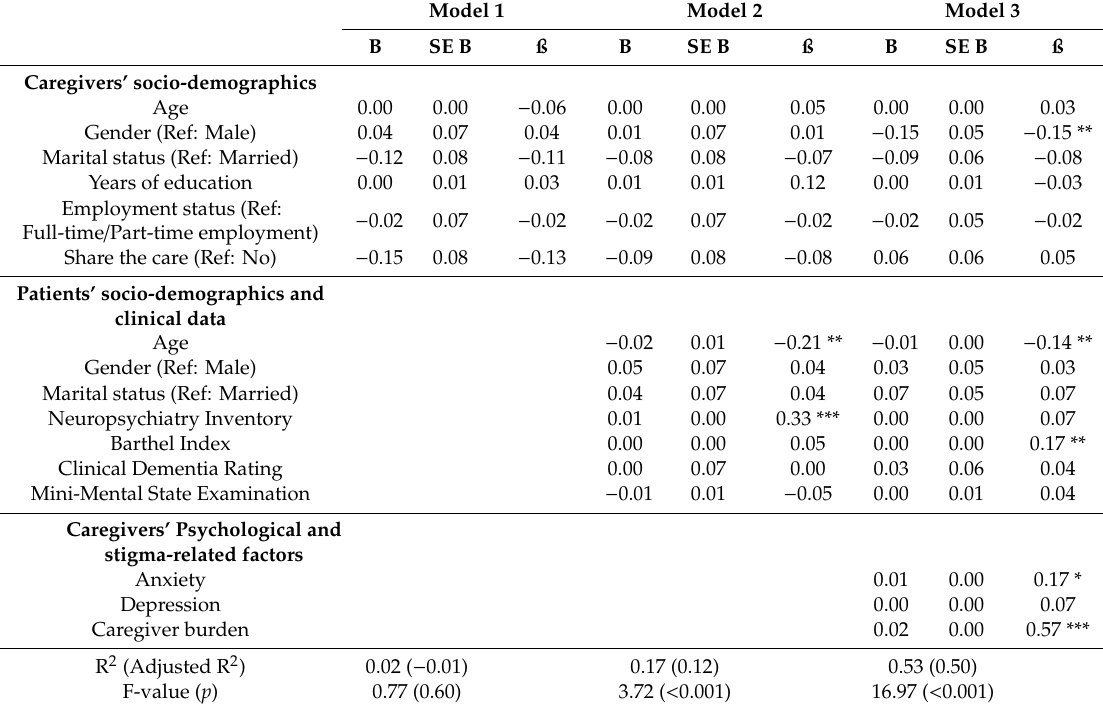
Table 4. Factors associated a ffi liate stigma analyzed by hierarchical regression